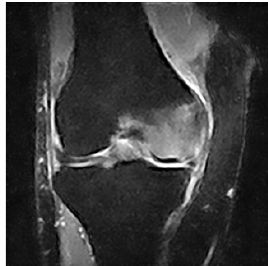
Figure 1. Coronal MRI image showing a typical BME pattern of our patients.